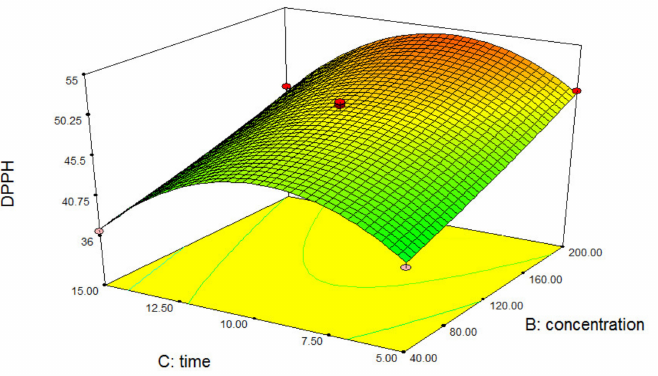
Figure 3. Three-dimensional figure showing the interactive effects of 3 factors (intensity, concentra- tion, and time). The response surface plot represents the effects of the concentration and time on diphenyl-1-picrylhydrazyl.